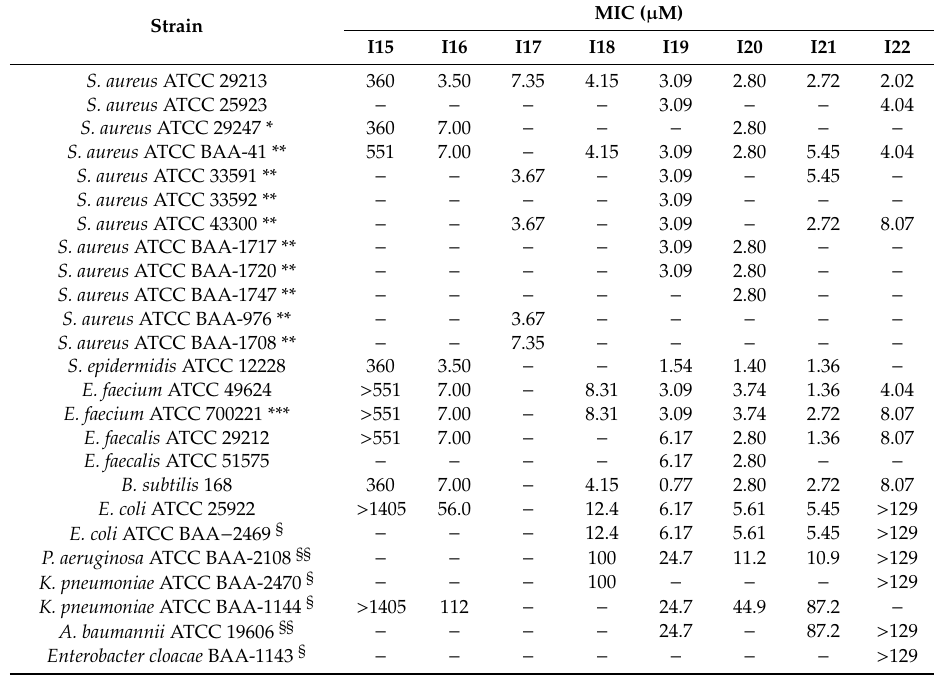
Figure 8. Berberine-based inhibitors. Table 8. MICs of berberines